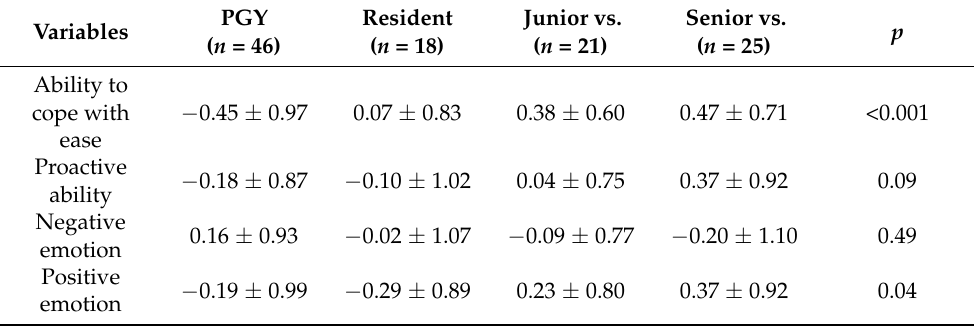
Table 2. Measurement of the self-efficacy and emotional traits of the subjects with different seniority levels in coping with the COVID-19 pandemic. The results were expressed as mean ± standard deviation (SD).